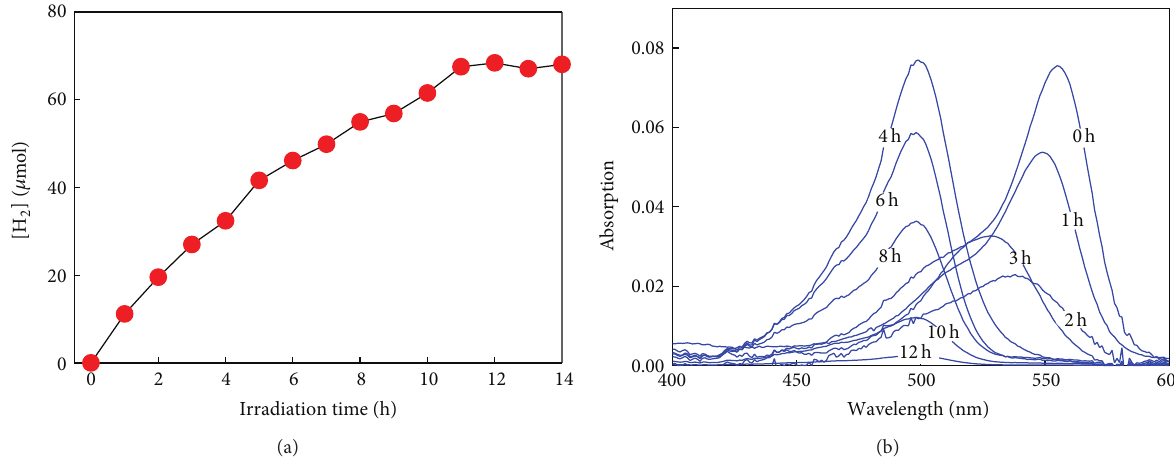
Figure 6: Long-term experiment for the simultaneous (a) production of H 2 and (b) degradation of RhB in the suspension of Pt/TiO 2 /Nf. Experimental conditions: [catalyst] = 0.5 gL −1 , [RhB] = 20 𝜇 M, [EDTA] = 4mM, pH 𝑖 = 2.3 , and 𝜆 > 420 nm. Samples were diluted by 3 times for the analysis (for part